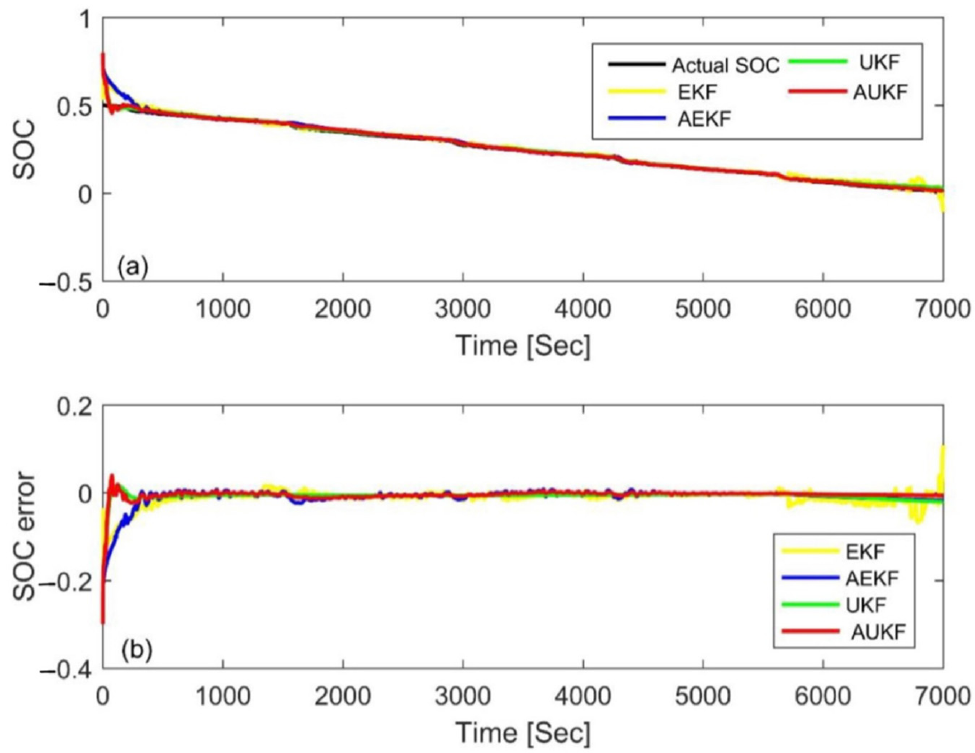
Figure 14. Estimation results at an initial SOC of 80% via the FUDS. ( a ) SOC estimation comparison curve; ( b ) SOC estimation error.